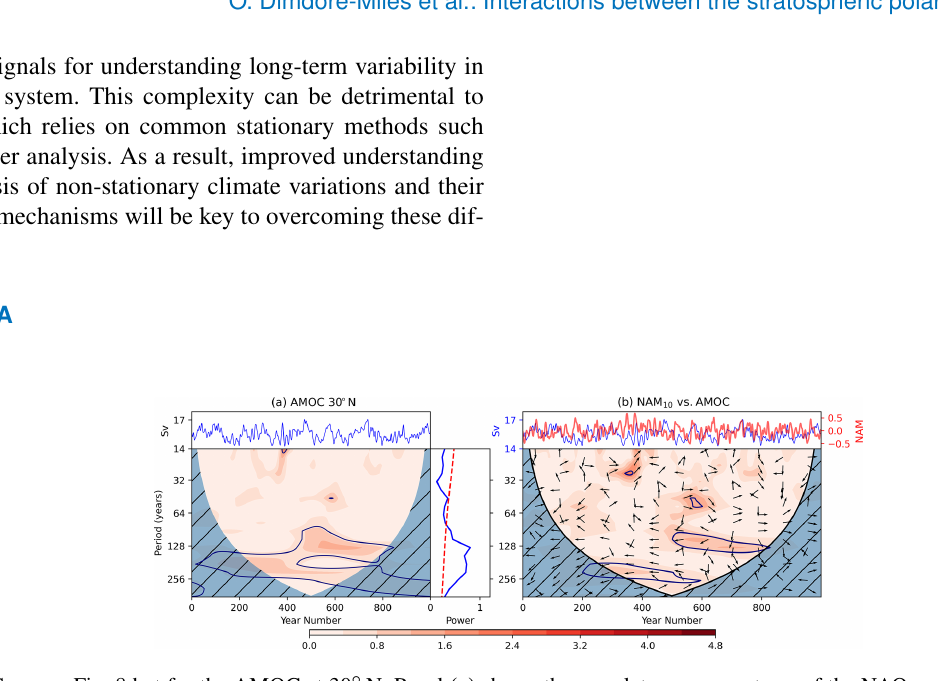
Figure A1. Same as Fig. 8 but for the AMOC at 30 ◦ N. Panel (a) shows the wavelet power spectrum of the NAO, and panel (b) shows the cross-power spectrum between the AMOC and the NAM 10 index.